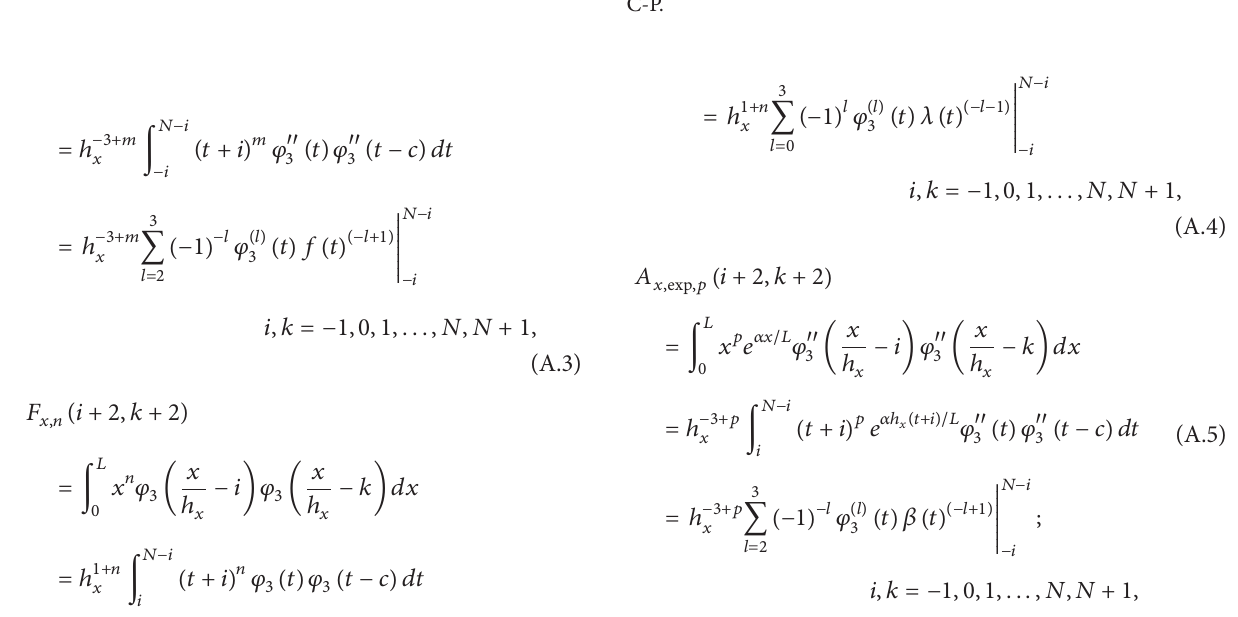
Figure 15: Variation of first three nondimensional natural frequen- cies of an axially FG beam with respect to 𝛼 ; boundary condition: